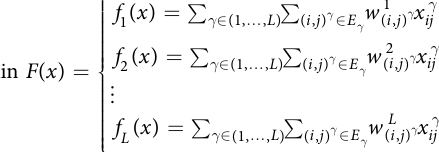
(cid:31)(cid:30) G is a two-layer multiplex (cid:31)(cid:30) G is the (cid:31)(cid:30) G